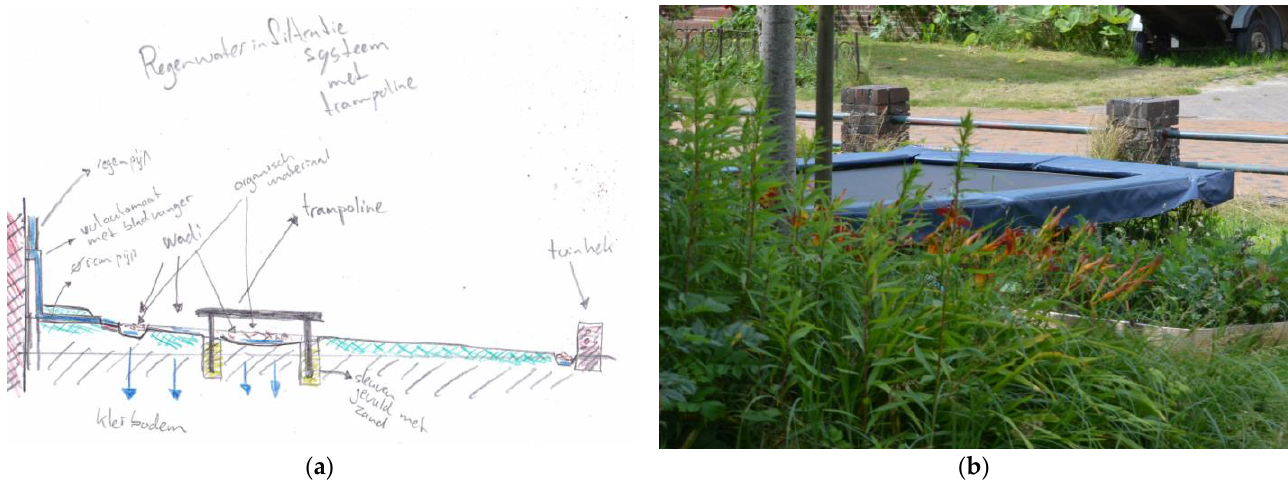
Figure 4. ( a )Trampoline with water storage, technical sketch (source: climatescan.org) and ( b ) photo of the actual imple- mentation.